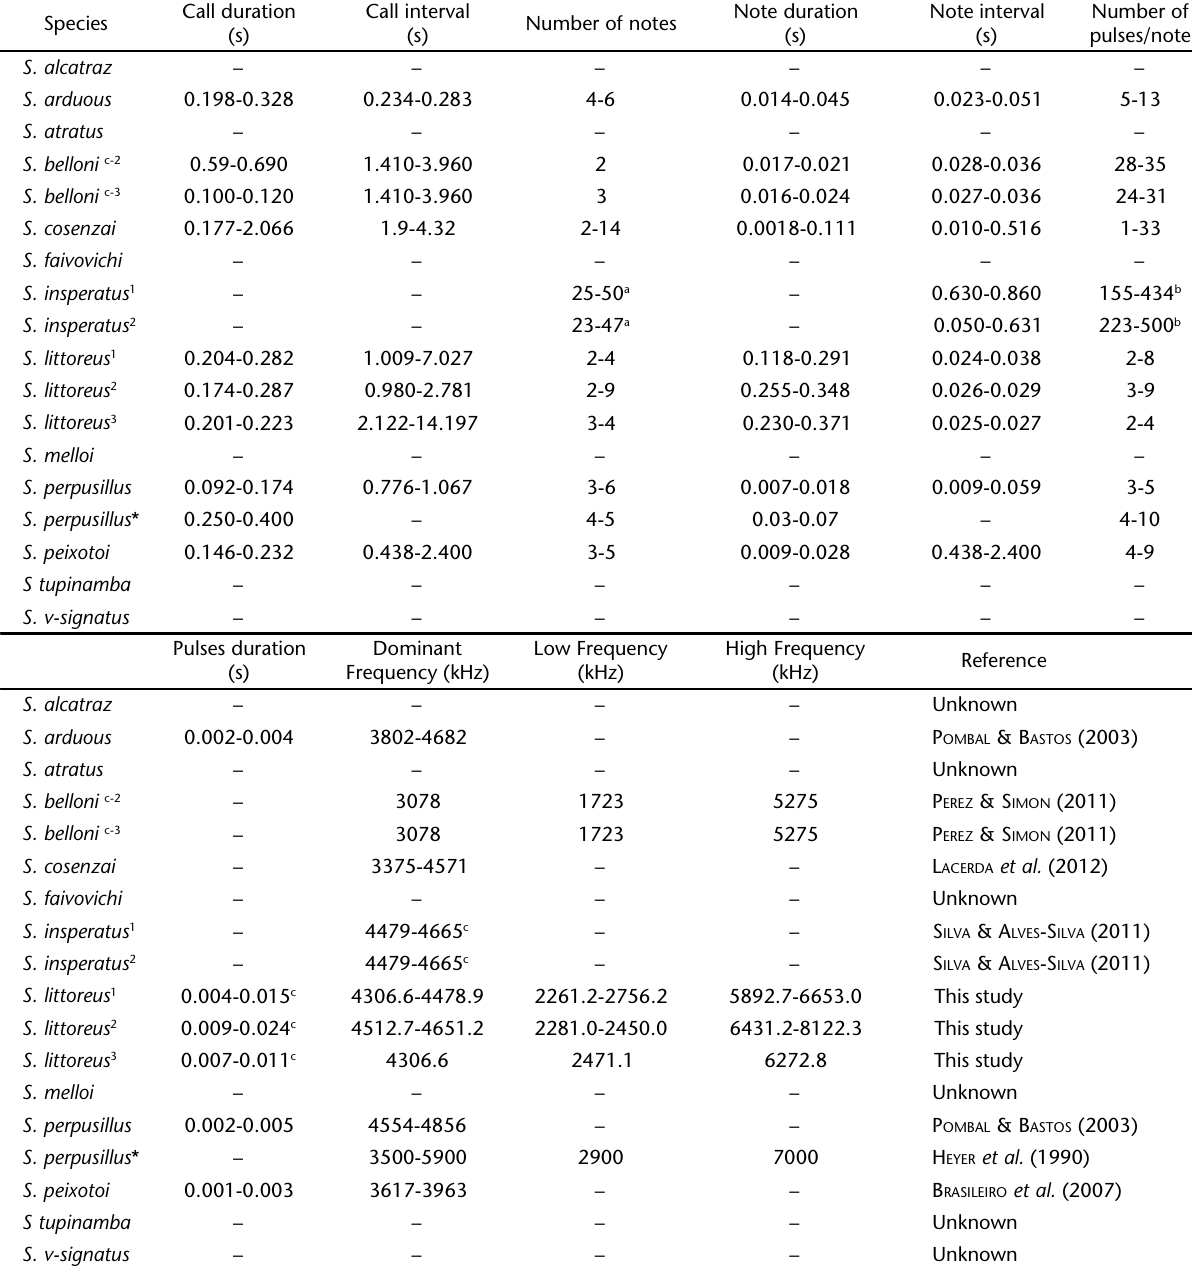
Table I. Comparative table of known advertisement calls of Scinax perpusillu s group. Data are given as minimum-maximum.